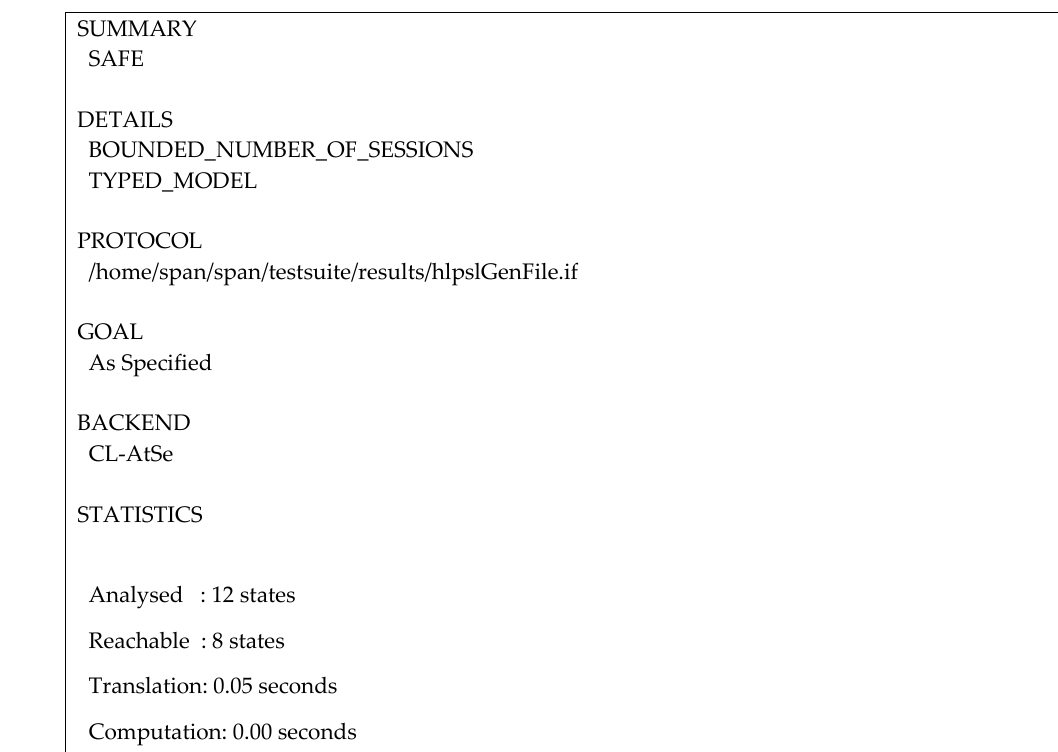
Figure 13. Constraint Logic-based Attack Searcher (CL-AtSe) analysis result for PUP phase.